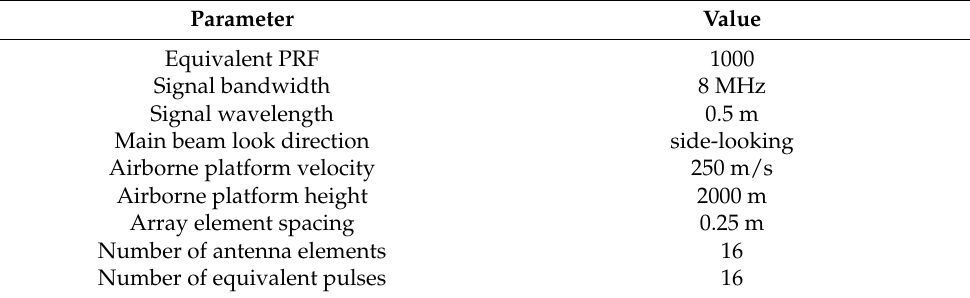
Table 2. Simulation parameters.